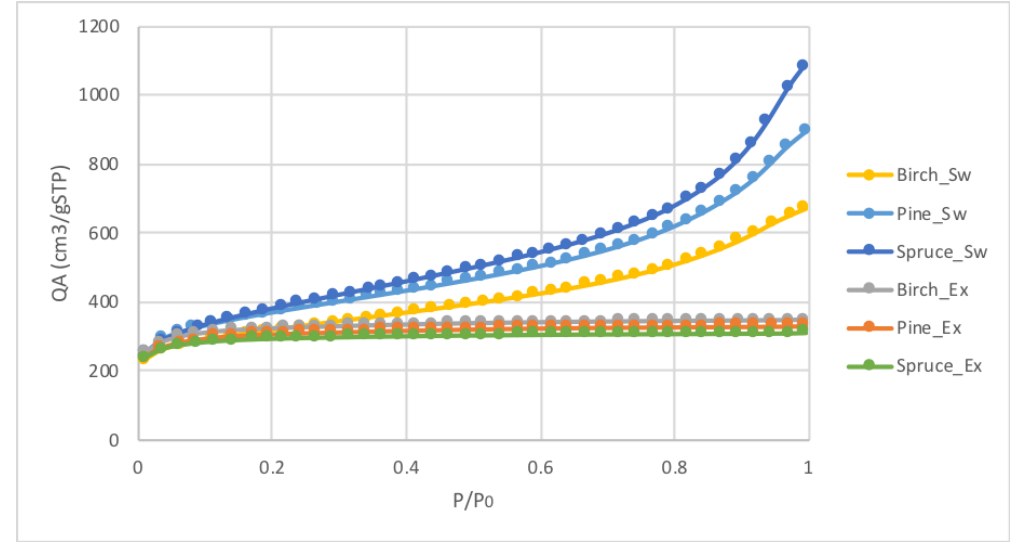
Figure 2. Isotherm comparison between unextracted and acetic acid-extracted wood-based AC. The isotherms obtained from the untreated samples were all Type II, indicating the presence of Table 4. Porosity characteristics of the ACs produced from unextracted and extracted sawdust. mesopores. Isotherms obtained from the extracted samples before carbonization and activation were all Type I, indicating that most of the pores were in the micropore region. Calculation